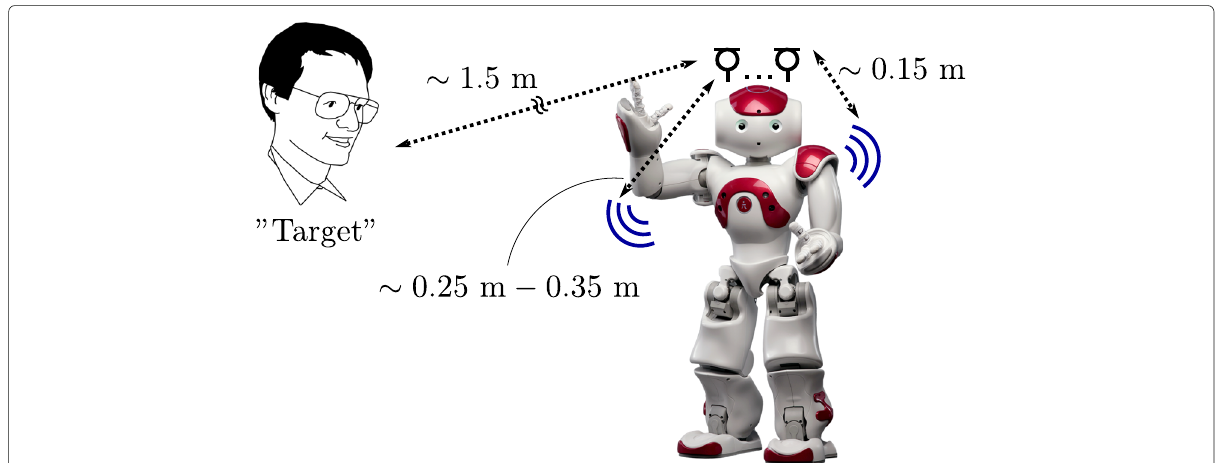
Fig.1 Illustrationofatypicalhuman-robotinteractionscenario.The desiredsource("target")isshownontheleft.Twoexemplary,spatiallydistributed ego-noise sources are shown in blue. Besides, typical distances between the sources and the microphones are given. Obviously, the ego-noise sources are located close to the microphones while the distance between target and microphones is typically larger. Image of robot taken from [12]